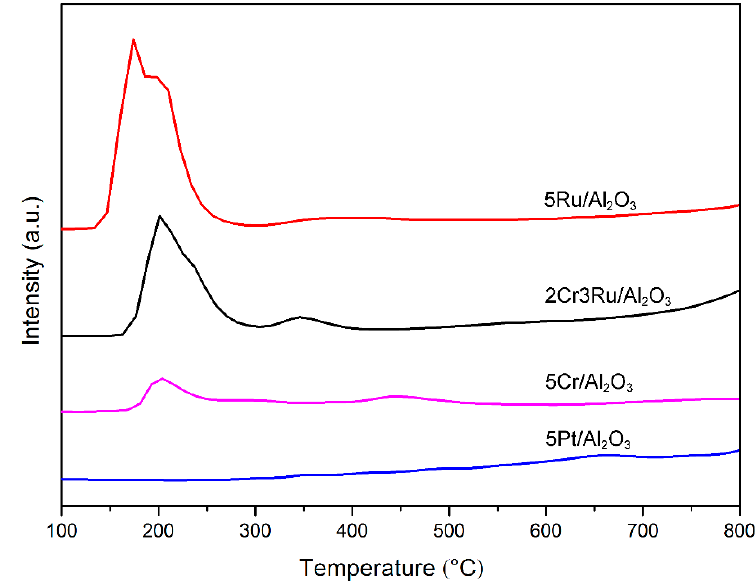
Figure 4. H 2 -TRP profiles of fresh 5Pt, 5Ru, 5Cr, and 2Cr3Ru supported on Al 2 O 3 .